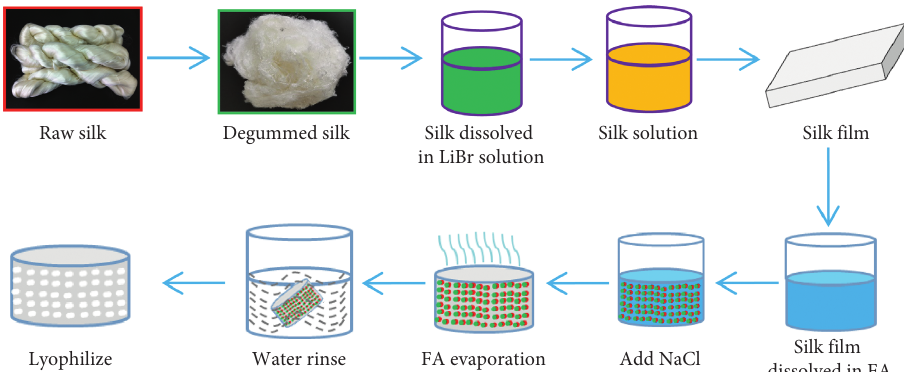
Figure 1: The scheme of the basic process to prepare porous silk scaffolds.